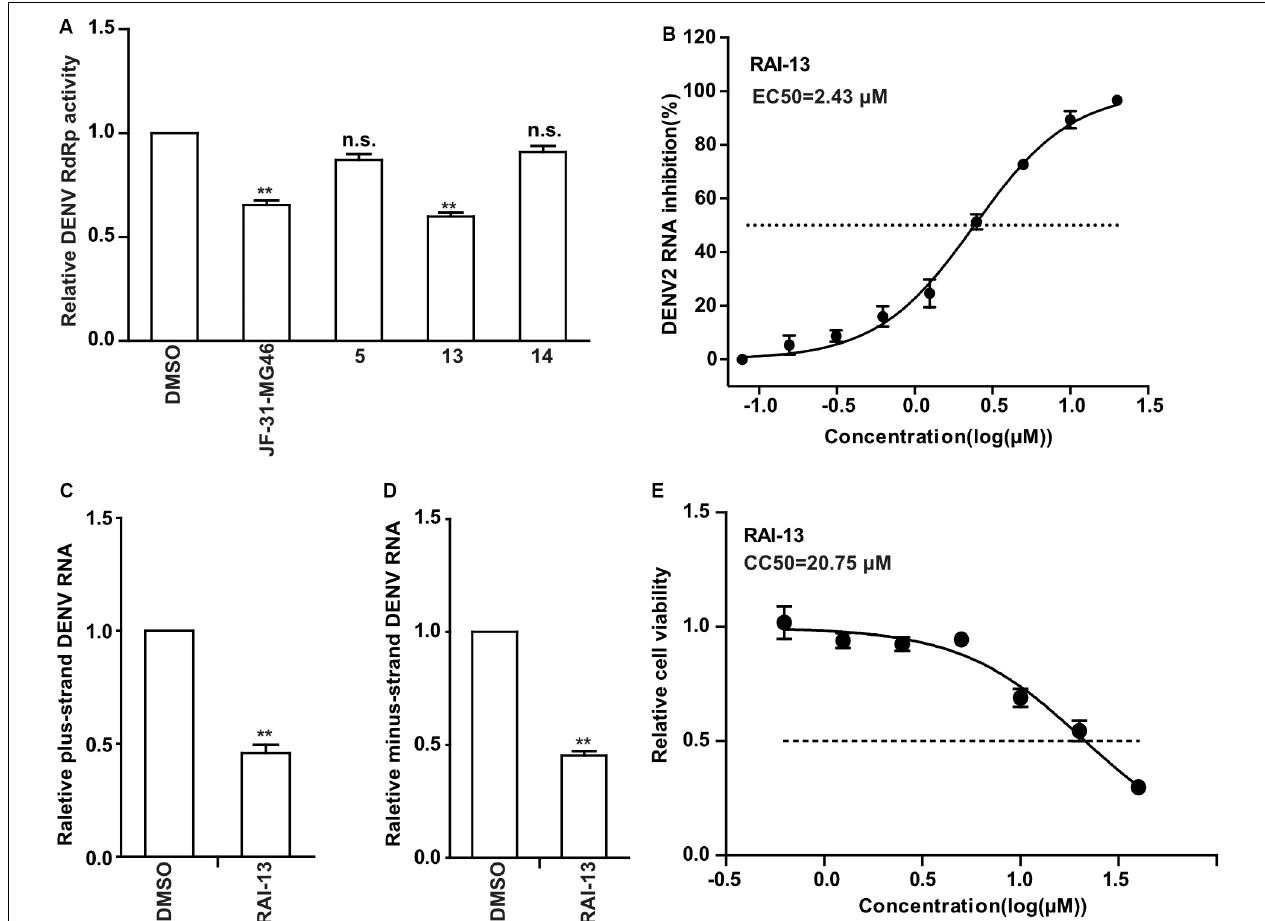
FIGURE 5 | Inhibitory Effects of RAI-13 against DENV RdRp activity and RNA replication. (A) The inhibitory effect of RAI-5, RAI-13, and RAI-14 on the activity of DENV RdRps were measured by DENV-RdRp inhibition assay in vitro at a concentration of 40 µ M. DMSO and JF-31-MG46 were selected as negative and positive control, respectively. The experiments were performed in triplicate. (B) Anti-DENV activity in cell culture. Two-fold serially diluted RAI-13 (from 0.08 to 20 µ M) were incubated with DENV2 in A549 cells for 48 h. The inhibition of RAI-13 against DENV2 replication was measured by detecting DENV2 RNA through qRT-PCR analysis. EC50 values were obtained by non-linear regression analysis using GraphPad 5.0. The Data are representative of three independent experiments and values are expressed in mean ± SD. (C,D) DENV2 infected cells were treated with 2 µ M RAI-13. The levels of relative plus-strand and minus-strand DENV2 RNA were measured by qRT-PCR. Error bars indicate standard deviations ( n = 3). (E) The cytotoxicity of the RAI-13 was measured using a Cell Counting Kit-8 by following the manufacturer’s instructions, CC50 values were obtained by non-linear regression analysis using GraphPad 5.0. Data shown are means ± s.d. n = 3. P values were calculated using a two-sided paired t -test. The significance of differences is indicated in the figures (* P < 0.05; ** P < 0.01; *** P < 0.001; and n.s., not significant).